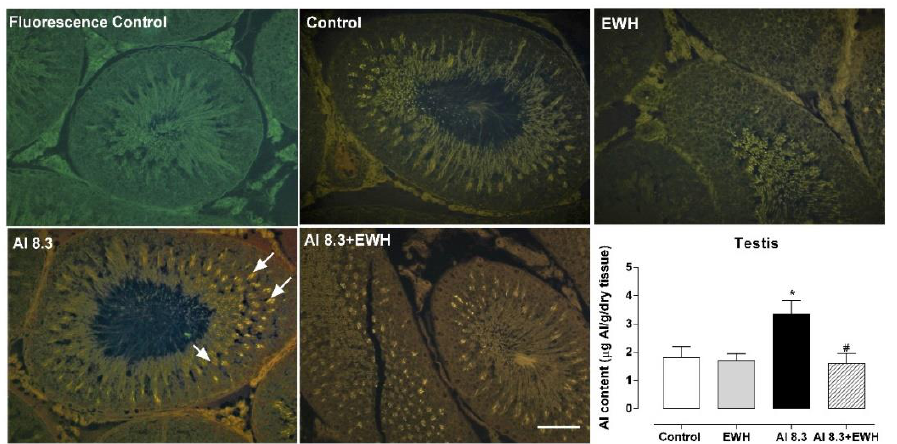
Figure 6. Effects of EWH on aluminum content in testis of rats exposed to AlCl 3 at 8.3 b.w. per day. Representative testis sections showing lumogallion fluorescence for presence of aluminum (arrows), auto-fluorescence and nonspecific fluorescence in control and EWH treated rats. Scale bar: 50 µ m. Graph: Al content ( µ g Al/g tissue dry mass) in testis determined by TH GFAAS (Transversely Heated Graphite Furnace Atomic Absorption Spectrometry). Data are expressed as mean ± SEM, n = 5, * p < 0.05 compared with the corresponding control, # p < 0.05 compared with AlCl3 group (two-way ANOVA and Bonferroni as post-hoc